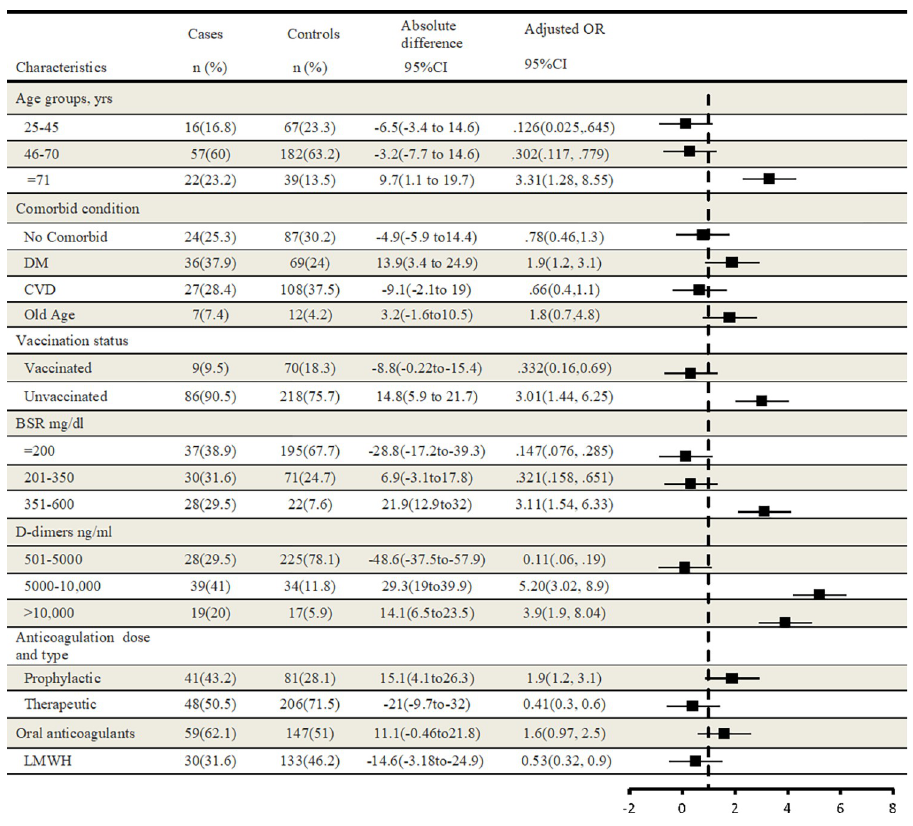
Fig 1. Association between predictor variables and development of neurological complications among COVID-19 patients. DM (Diabetese Mellitus), CVD (cardiovascular Diseases), BSR (blood sugar random), LMWH (Low molecular weight heparin). Association is measured in term of OR 95% CI shown in forest plot. In this model, an odds ratio < 1 indicated decreased likelihood of neurological complication, and vice